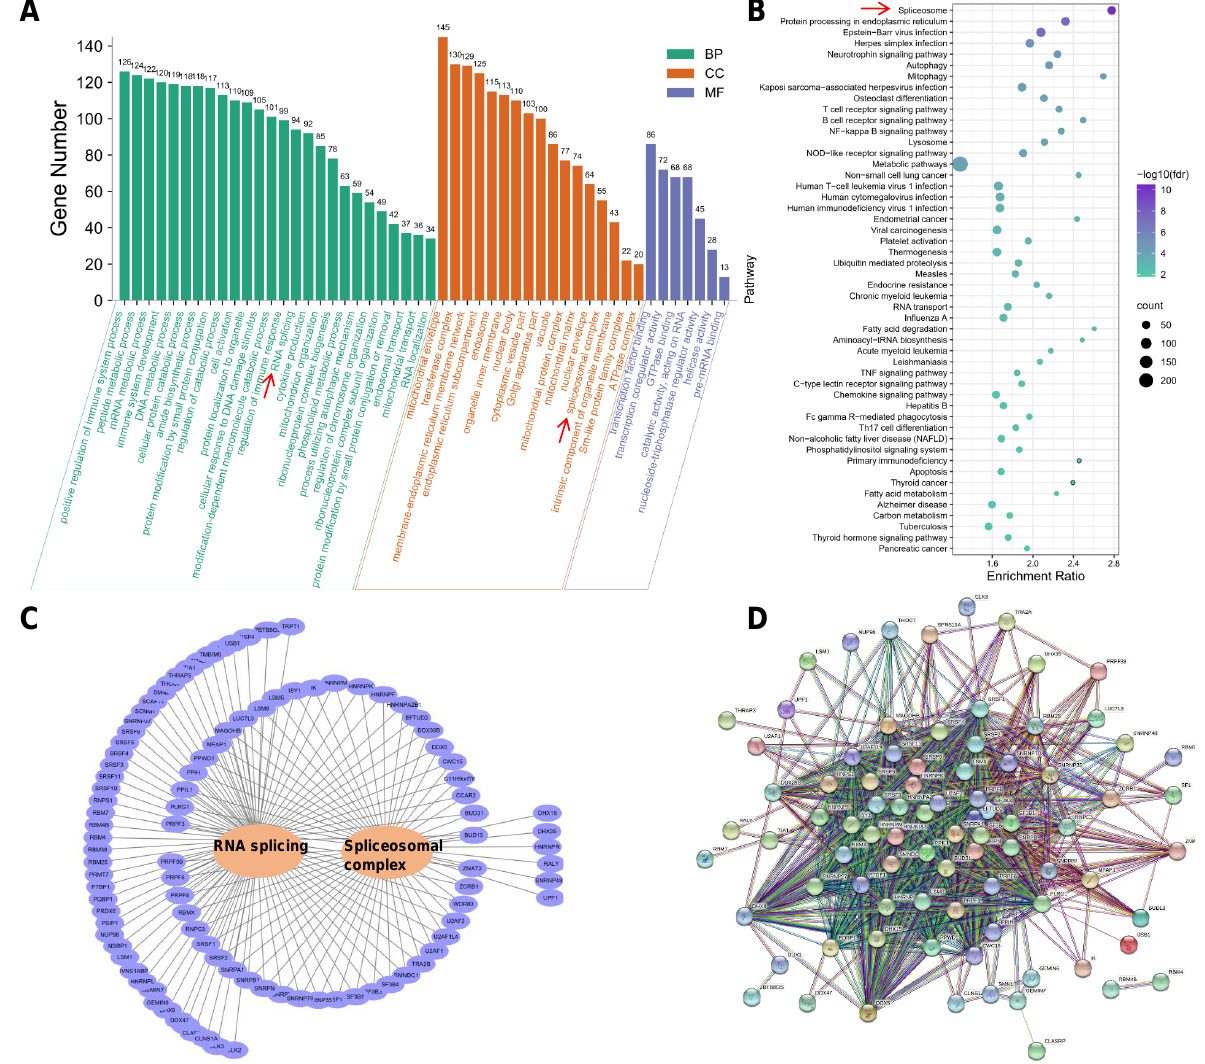
Figure 4. Gene Ontology (GO) and Kyoto Encyclopedia of Genes and Genomes (KEGG) annotation for differentially spliced genes. ( A ) GO terms. ( B ) KEGG pathways. ( C ) Interaction networks of genes involved in RNA splicing and spliceosomal complex. ( D ) Protein-protein interaction (PPI) of genes involved in RNA splicing and spliceosomal complex. BP: biological processes; CC: cellular components; MF: molecular